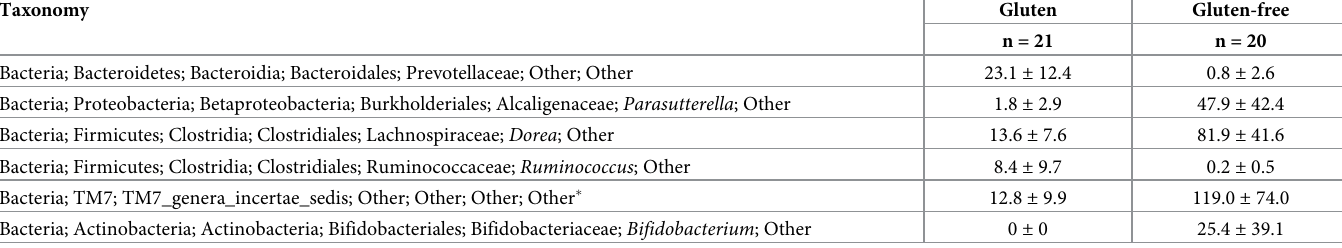
Table 2. Normalized relative abundances (Mean ± s.d.) of gut microbiota bacteria differing significantly (ANCOM) between female BALB/cBomTac, which were either fed standard wheat based Altromin diet (Gluten) or a modified gluten-free Altromin diet (Gluten-free) from the age of six to fourteen weeks. All mice were vaccinated with a tetanus vaccine. FDR-corrected q-value was 0.010.